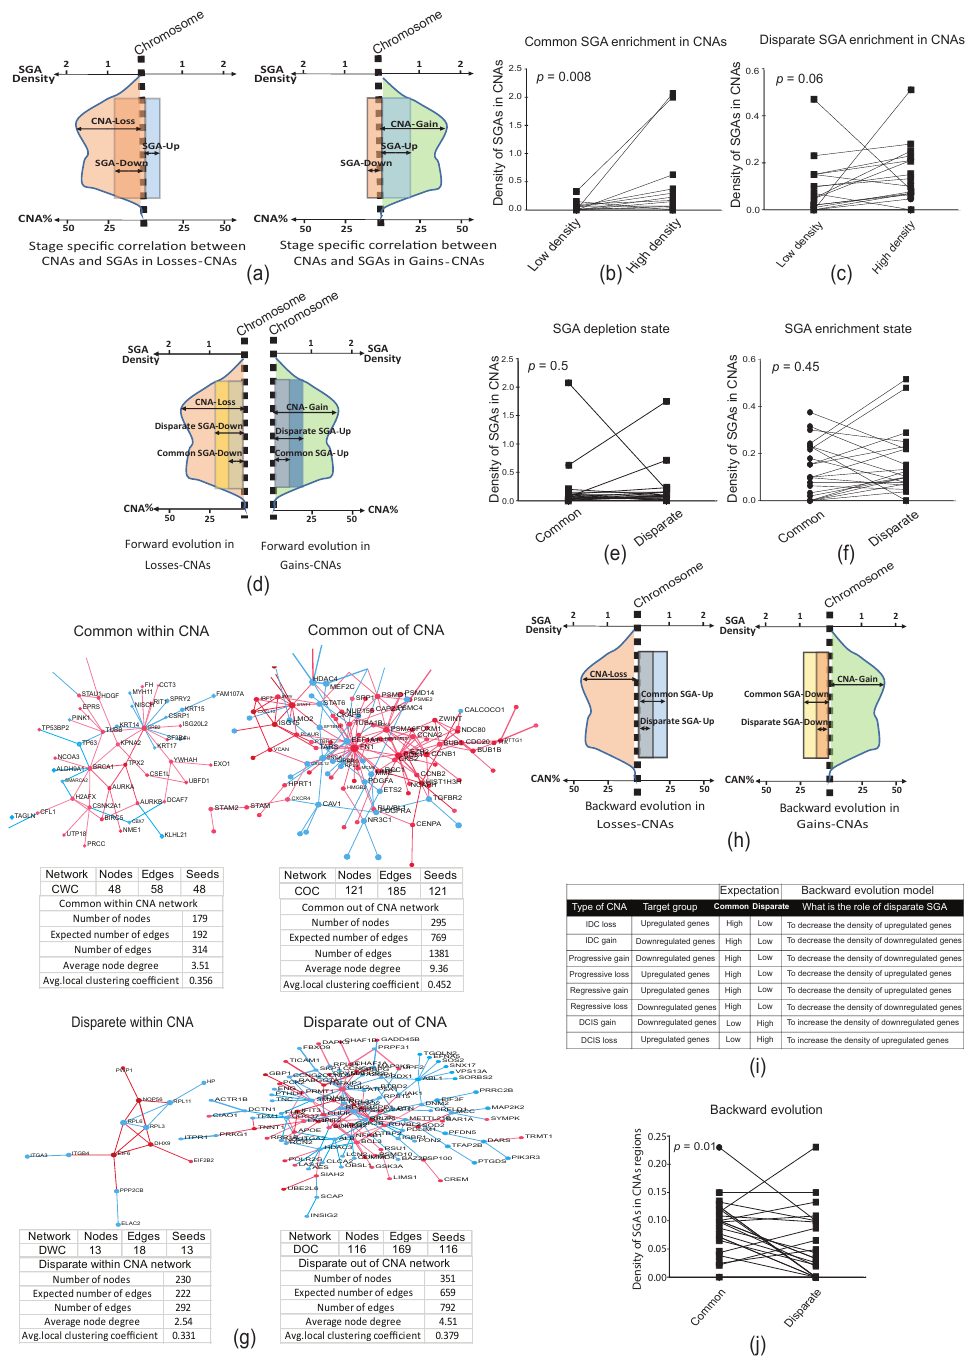
Figure 4. Evolutionary correlation models of SGAs and CNAs. ( a ) This scheme depicts the expectation of stage-specific correlation between the direction of CNAs and SGAs. It was expected that the density of upregulated SGAs would be higher than that of downregulated SGAs in gain CNAs (right) and the density of downregulated SGAs would be higher than that of upregulated SGAs in loss CNAs (left). ( b ) Common SGAs were correlated with the direction of CNA prototypes of DCIS. The density of downregulated genes was high in loss CNAs and the density of upregulated genes was high in gain CNAs (see Figure S4a). ( c ) Disparate SGAs were correlated with the direction of CNA prototypes